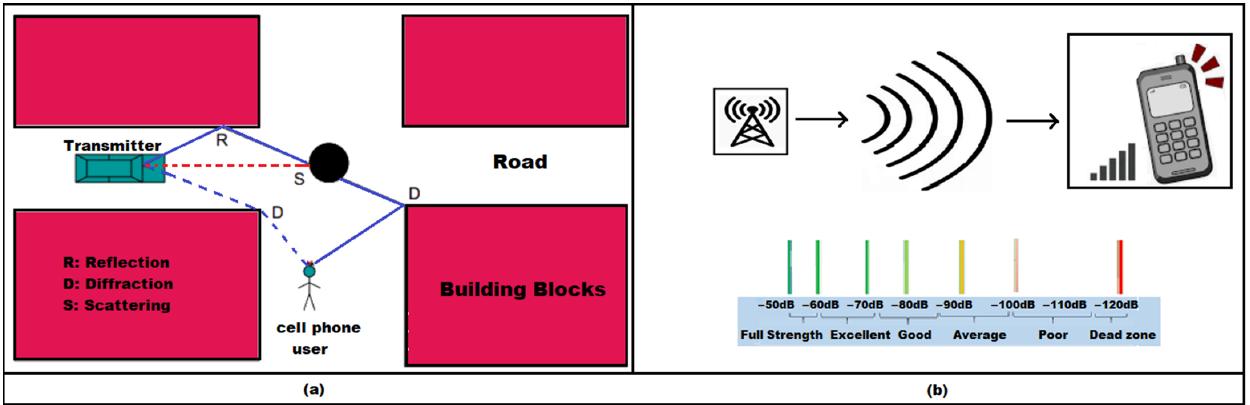
Figure 2. ( a ) Signal propagation, ( b ) Signal strength